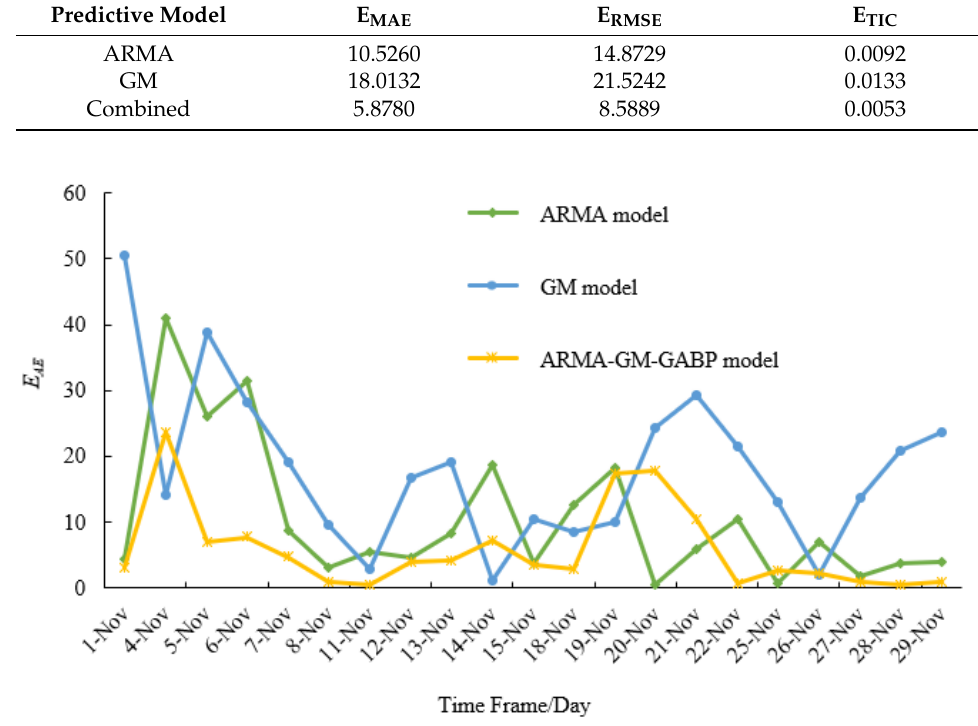
Table 3. Forecasting index of three models. Predictive Model